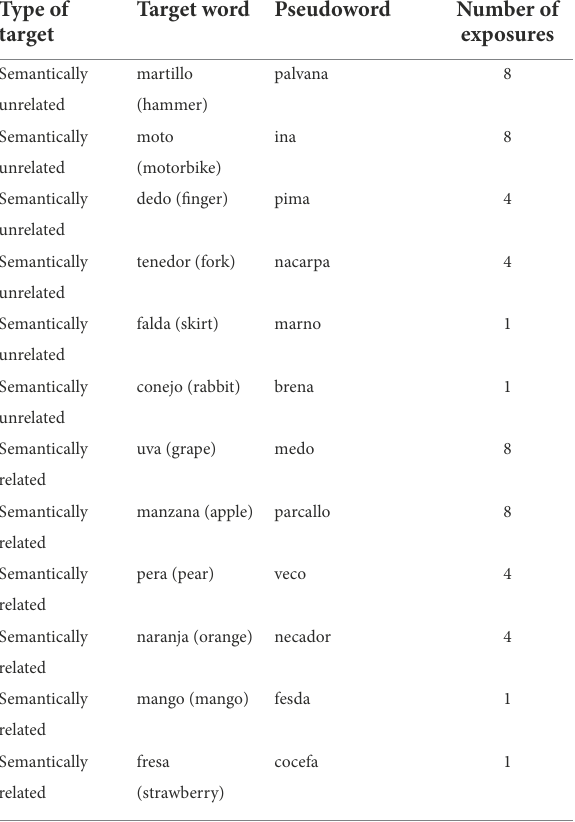
TABLE 1 Target words and pseudowords used in the experiment, together with the number of appearances of each of them (1, 4, 8), and their corresponding condition with regards to semantic clustering (related,